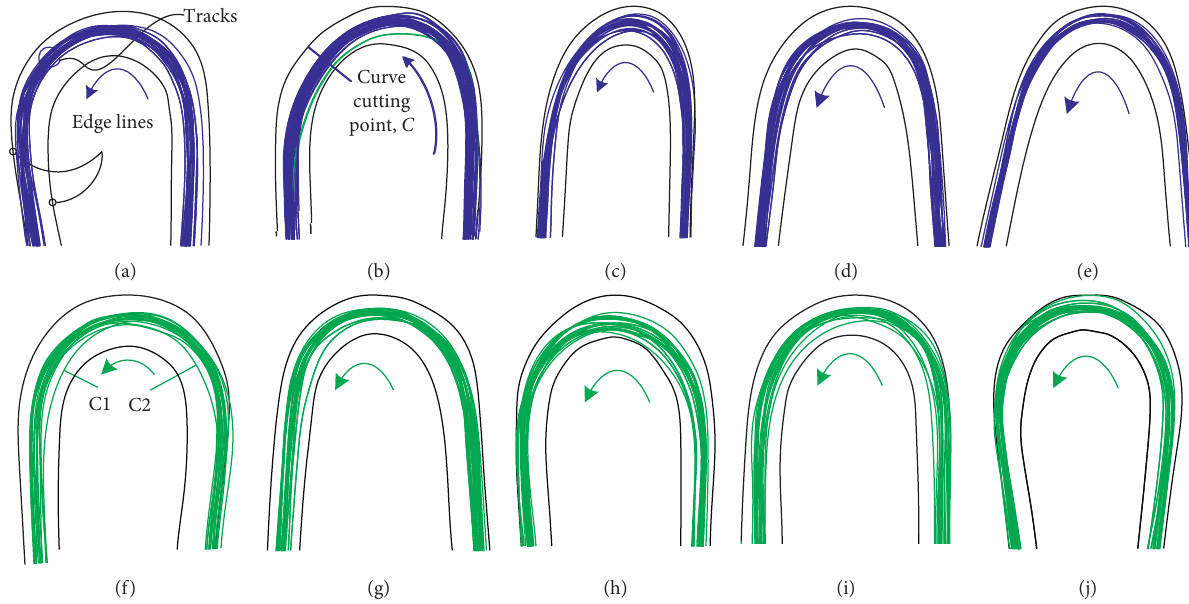
Figure 4: Left-turning traveling tracks at the hairpin curves. (a) Turn 1. (b) Turn 2. (c) Turn 3. (d) Turn 4. (e) Turn 5. (f) Turn 6. (g) Turn 8. (h) Turn 9. (i) Turn 10. (j) Turn